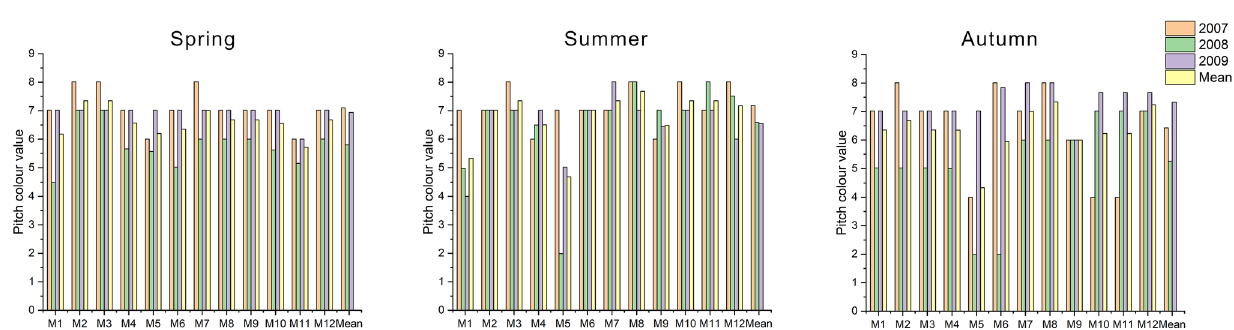
Figure 3. Ratings of pitch colour across grass mixtures and research years in different